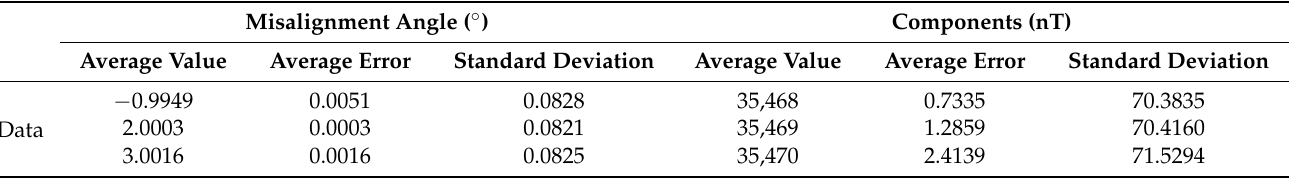
Table 5. Simulation results.